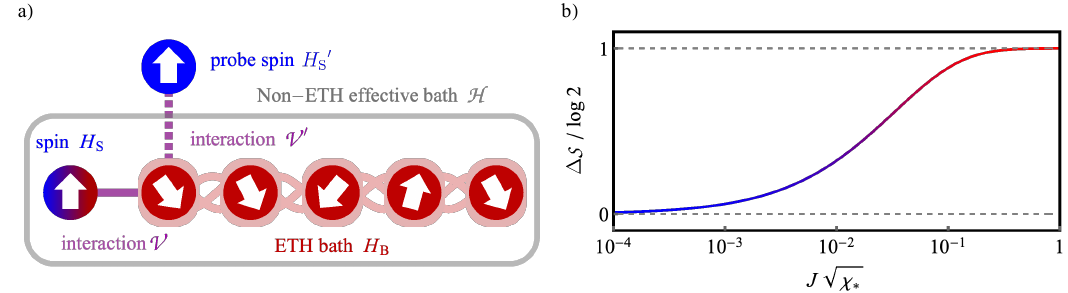
Figure 2: The Spin-ETH model as an ETH-like bath : a) at intermediate coupling, the Spin-ETH model appears as an effective bath to a second ‘probe’ spin. b) The entropy of the Spin-ETH model is enhanced from zero to log2 as the coupling to the first spin (cid:112) χ (cid:28) is tuned in the range 1 / d (cid:174) J (cid:63)